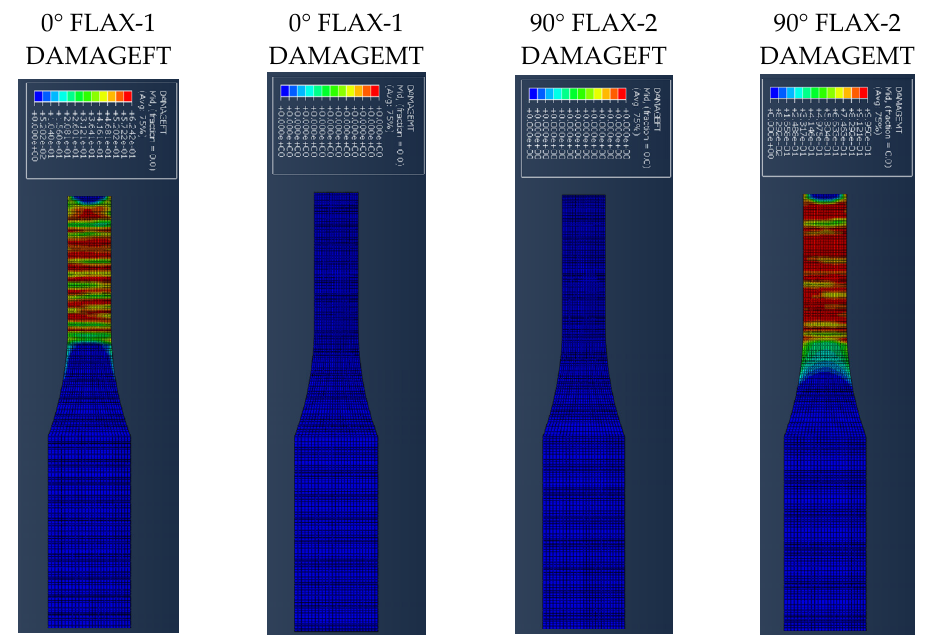
Figure 11. Stress distribution of each top layer of laminate B at 0.5 mm displacement and.